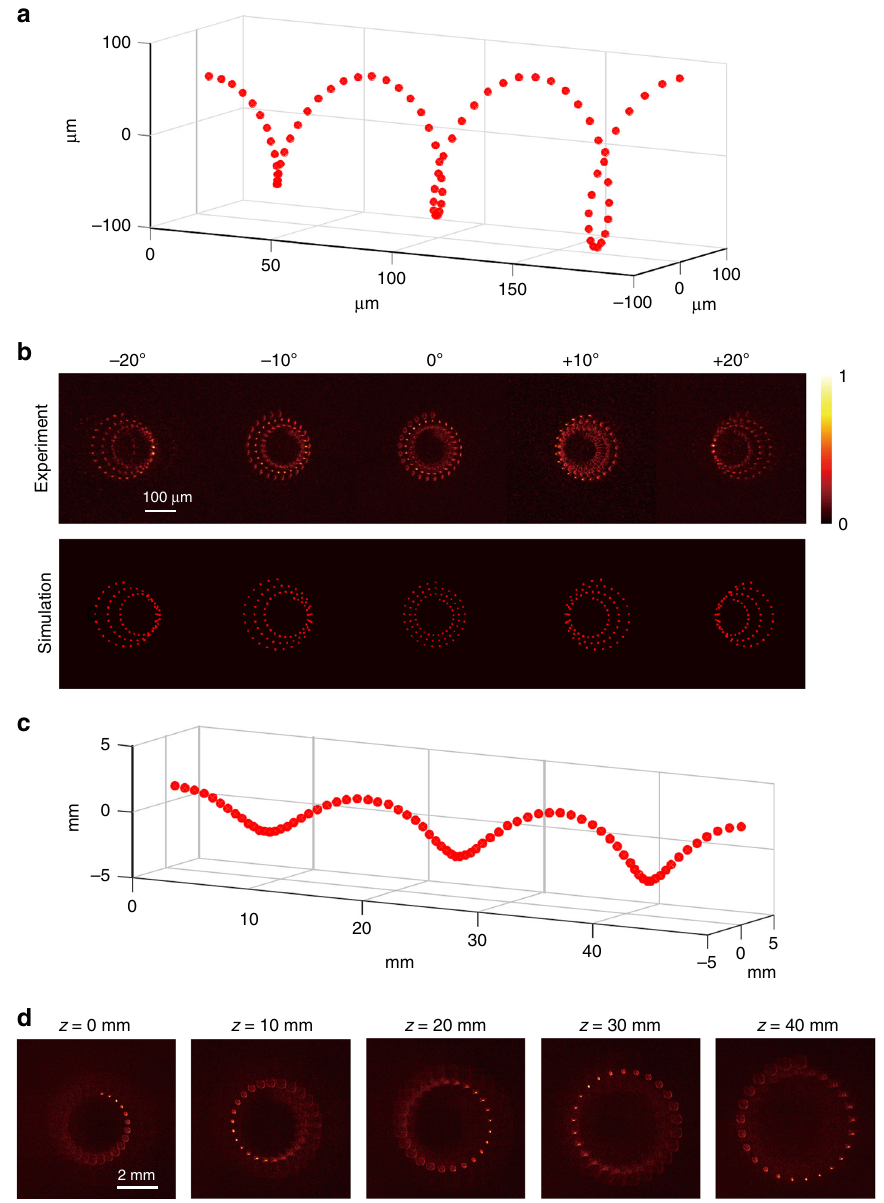
Fig. 3 Holographic images of 3D helixes. To demonstrate the motion parallax of holographic images, a helix consisting of 75 foci was generated and placed within a depth of focus of the proposed imaging system. a Geometry of the holographic helix. b 2D intensity images captured at different observation angles using the 4- f telescopic imaging system with a numerical aperture of 0.16 and corresponding simulation results. c Holographic image for projection in a large volume. The diameter of the helix varies from 0.25 cm to 0.5 cm with a length of 5 cm. d 2D intensity maps of the helical trajectory captured at each depth without lenses mounted on the